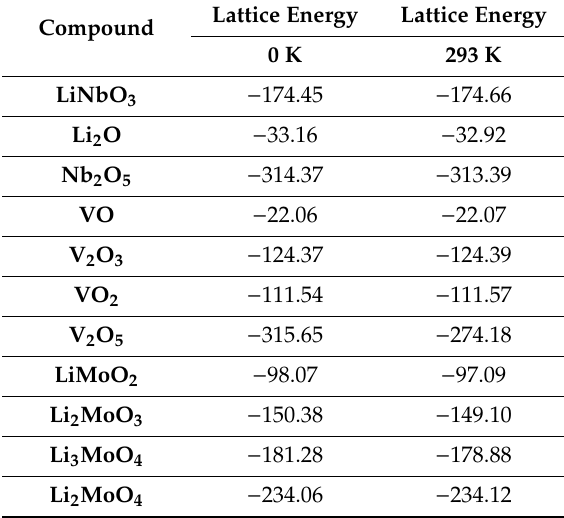
Table 11. Lattice energies used in the solution energy calculations (eV). Lattice Energy Lattice Energy Compound 0